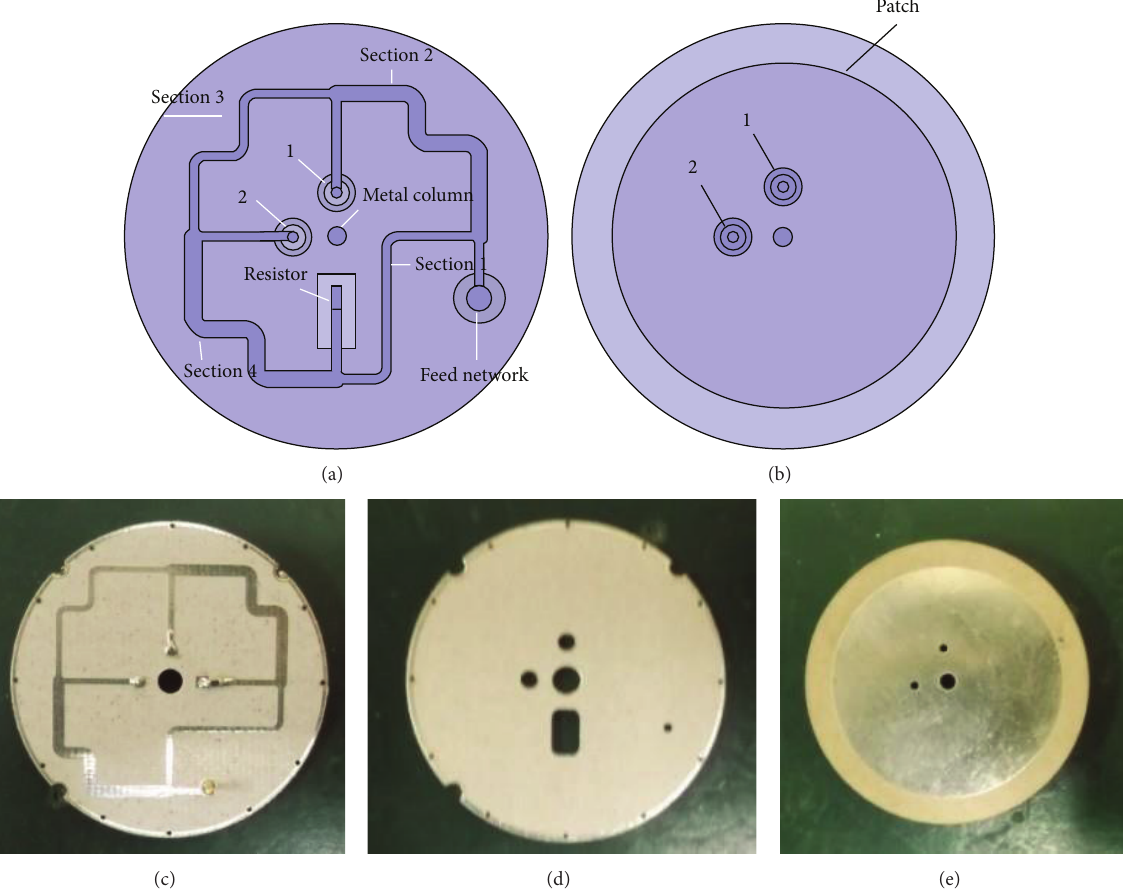
Figure 1: (a) shows the top view of the feed network which is a four-port strip line bridge, (b) is radiation patch on a thick PCB board of 4 mm, (c) is bottom view of the feed network photo, (d) is the other half of the feed network, and (e) is the photo of radiation patch. process. Actual processed strip line is always composed